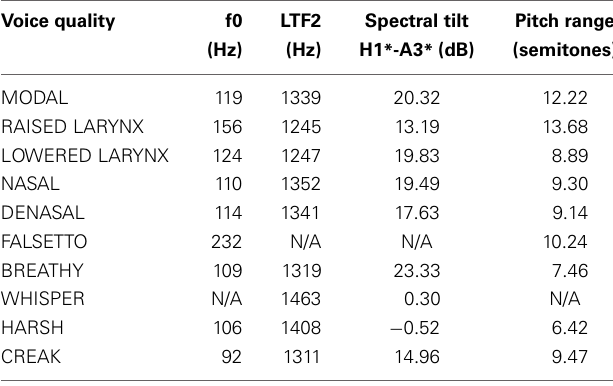
Table 1 | Acoustic values for the different voice qualities, averaging across speakers, and